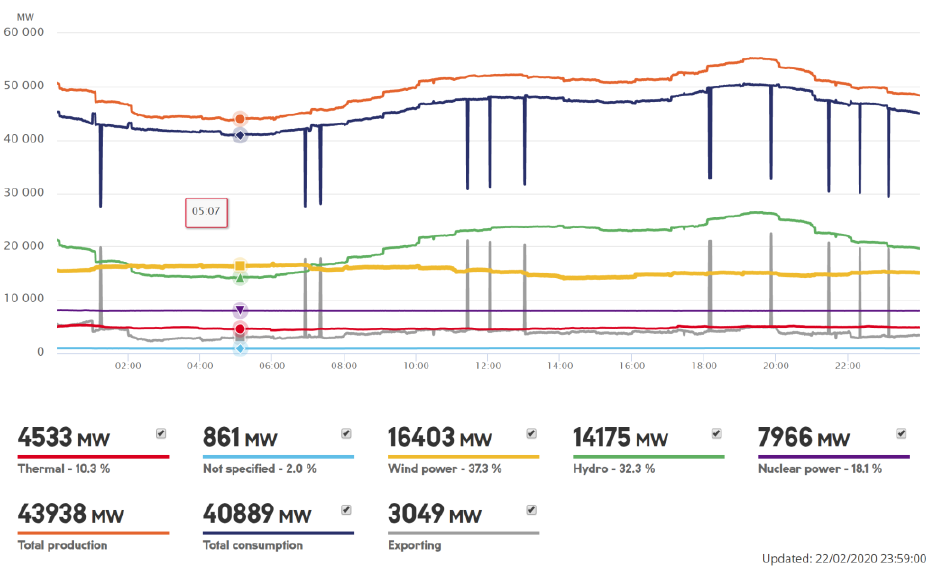
Fig. 1. Balance by production sources of the Nordic and Baltic power system on February 22, 2020. Source: www.stattnet.no; www.ast.lv; Nord Pool